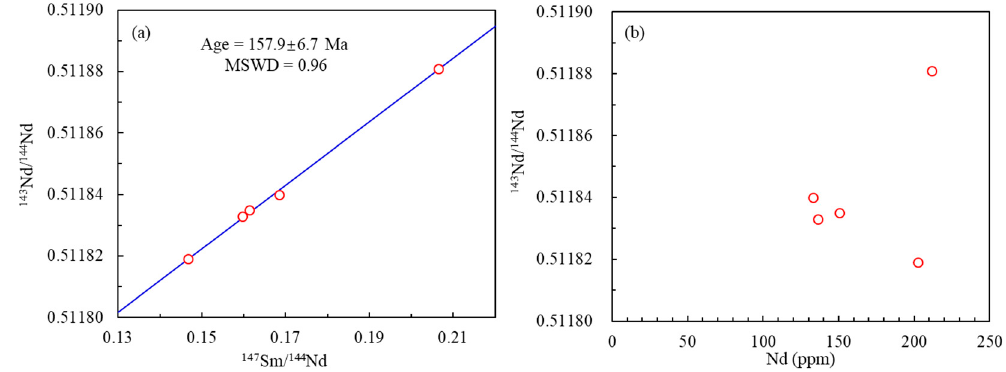
Figure 7. ( a ) Sm-Nd isochron, and ( b ) the relationship between 143 Nd / 144 Nd and Nd content obtained Figure 7. ( a ) Sm ‐ Nd isochron, and ( b ) the relationship between 143 Nd/ 144 Nd and Nd content obtained from scheelite of the Shangfang W from scheelite of the Shangfang W deposit.